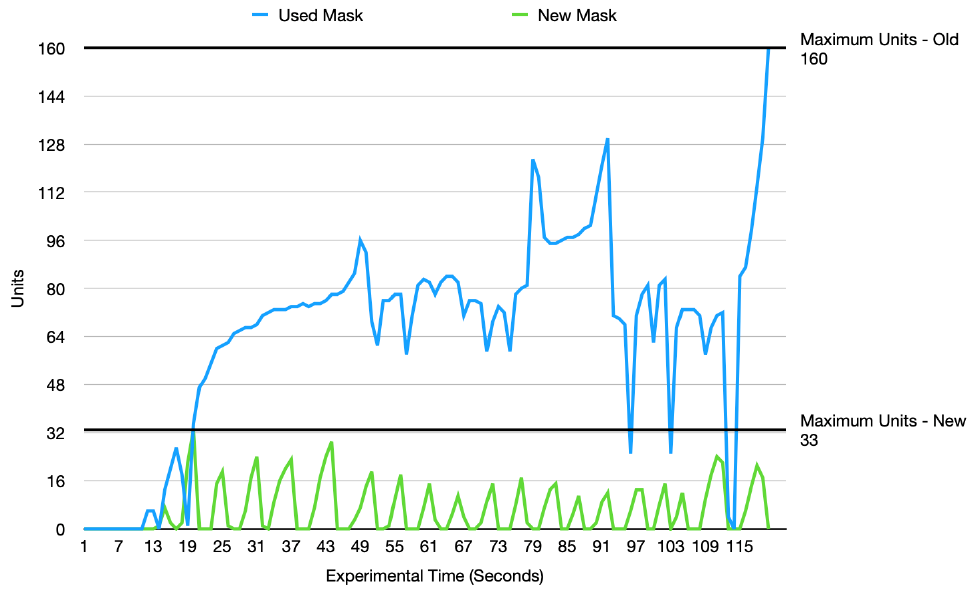
Figure 13. Humidity: Used Mask Vs. New